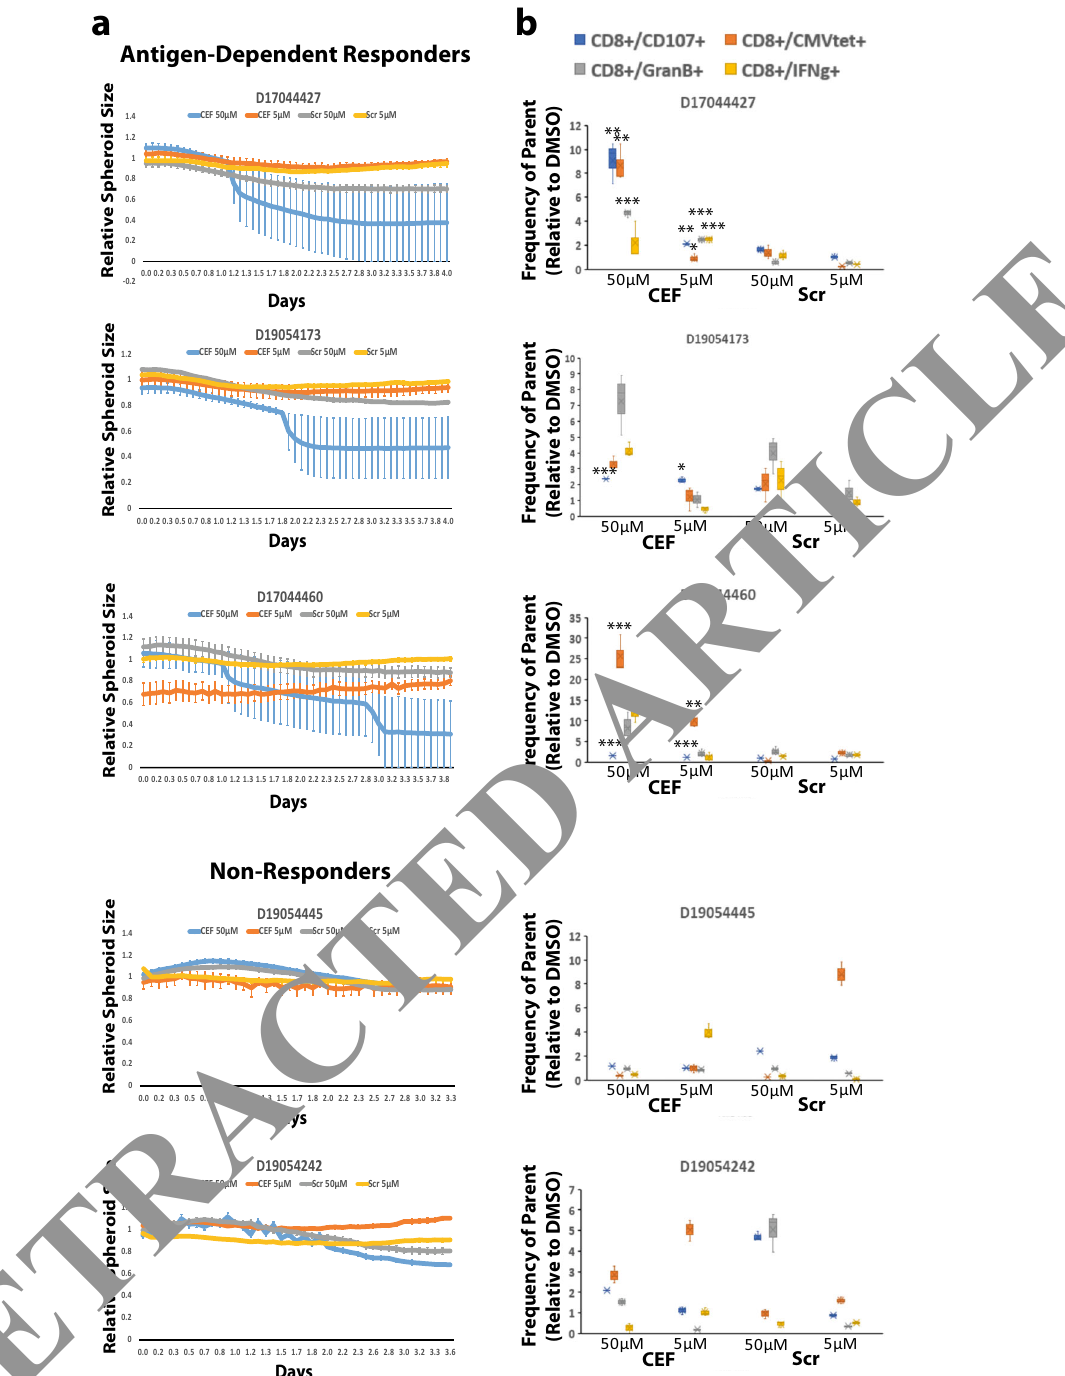
Fig. 8 Donor T-cell anti-tumor response to CDK4/6 inhibition correlates to canonical T-cell phenotypic markers. a Kinetic response of 6 normal human donor T-cells over 96 h under either high dose (50 μ M) or low dose (5 μ M) CDK4/6i treatment with matched peptides (CEF) or mismatched peptides (Scr). Data normalized to equivalent DMSO negative control samples; n = 3 independent experiments. b T-cell phenotyping data from fi ve patients from a showing populations of CD8 + -gated cells under all four CDK4/6i growth conditions. An independent sample t -test was used to calculate probability where * p < 0.05, ** p < 0.01, *** p < 0.001 compared to Scr negative control samples; n = 3 independent experiments and error bars indicate standard